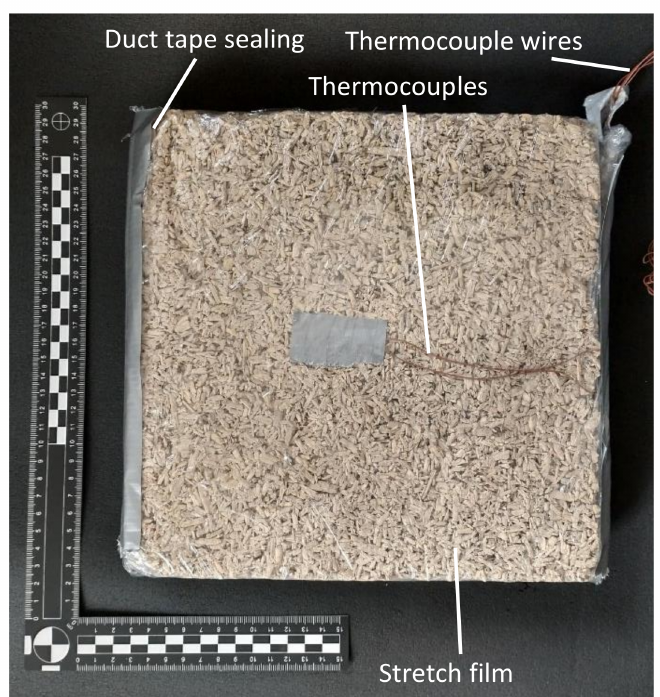
Figure 6. Samples prepared for measurement.